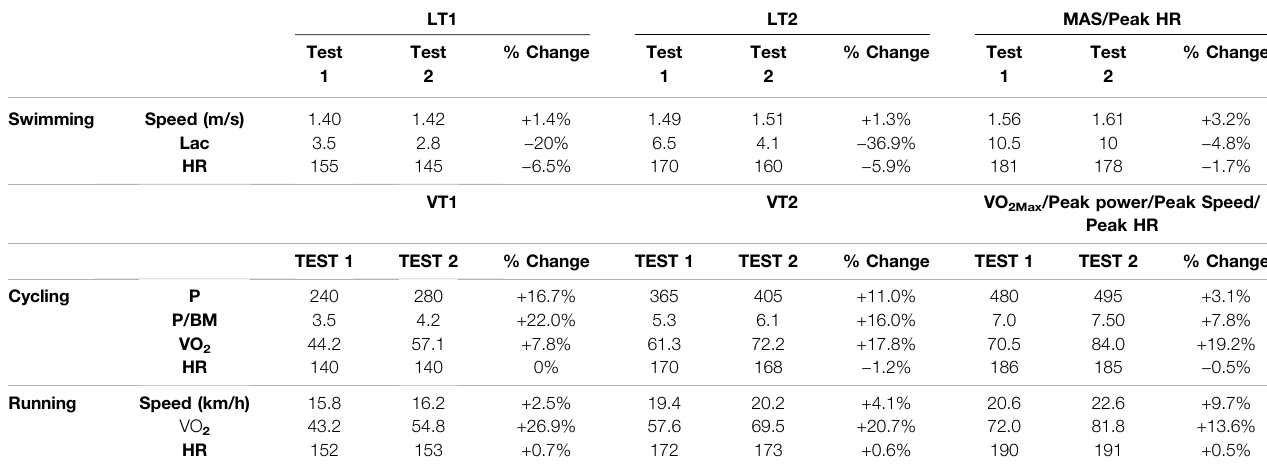
TABLE 3 | Change in physiological measures and performance during the season.